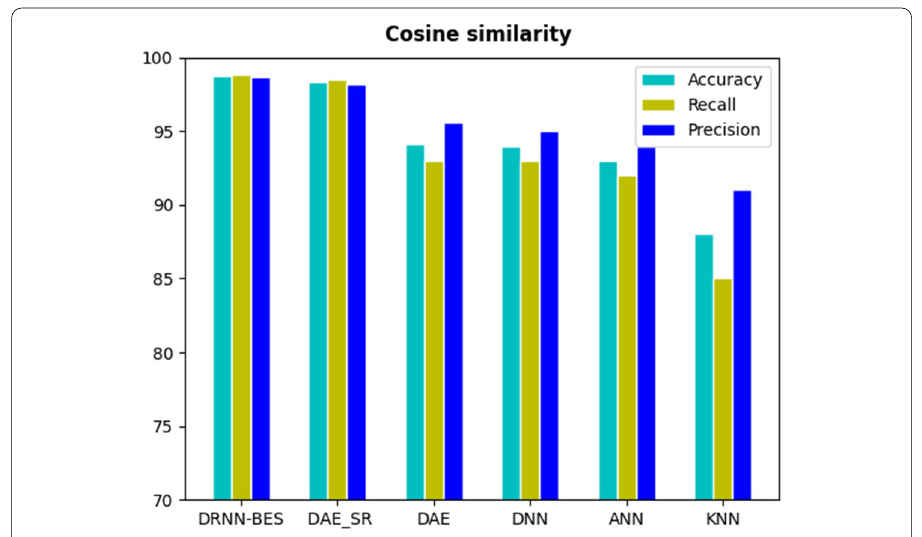
Fig. 6 Performance analysis based on cosine similarity